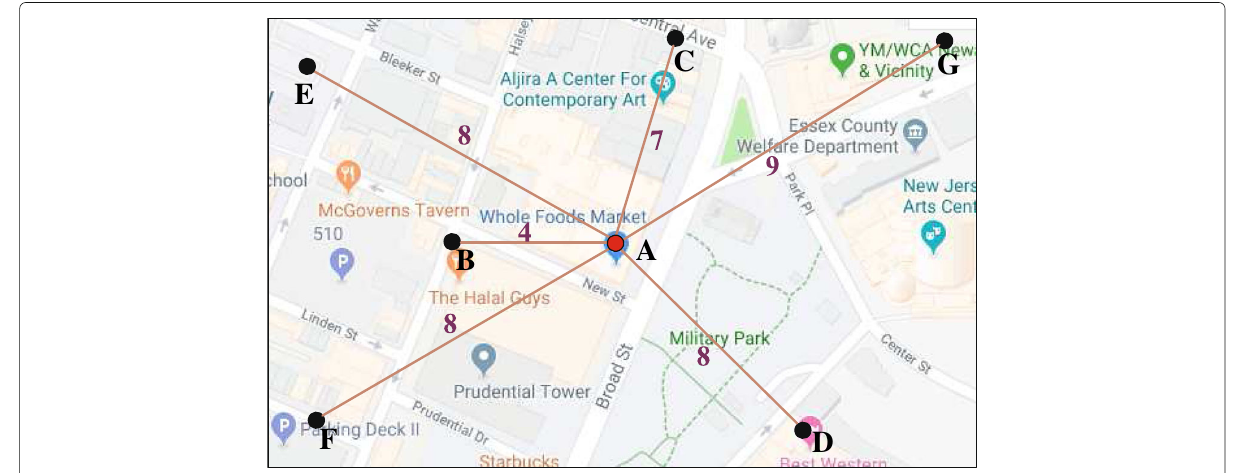
Fig. 2 Illustration of the neighbor user selection. It depicts a scenario that MSN users request LBS service. Dots represent the users, where red dot A represents the real user and other seven black dots represent the neighbor users. Eight users with labels { A , B , ··· , G } are deployed in the region. Lines between the dots indicate the spatial neighbor relation between the users, where the digits marked on the lines indicate the